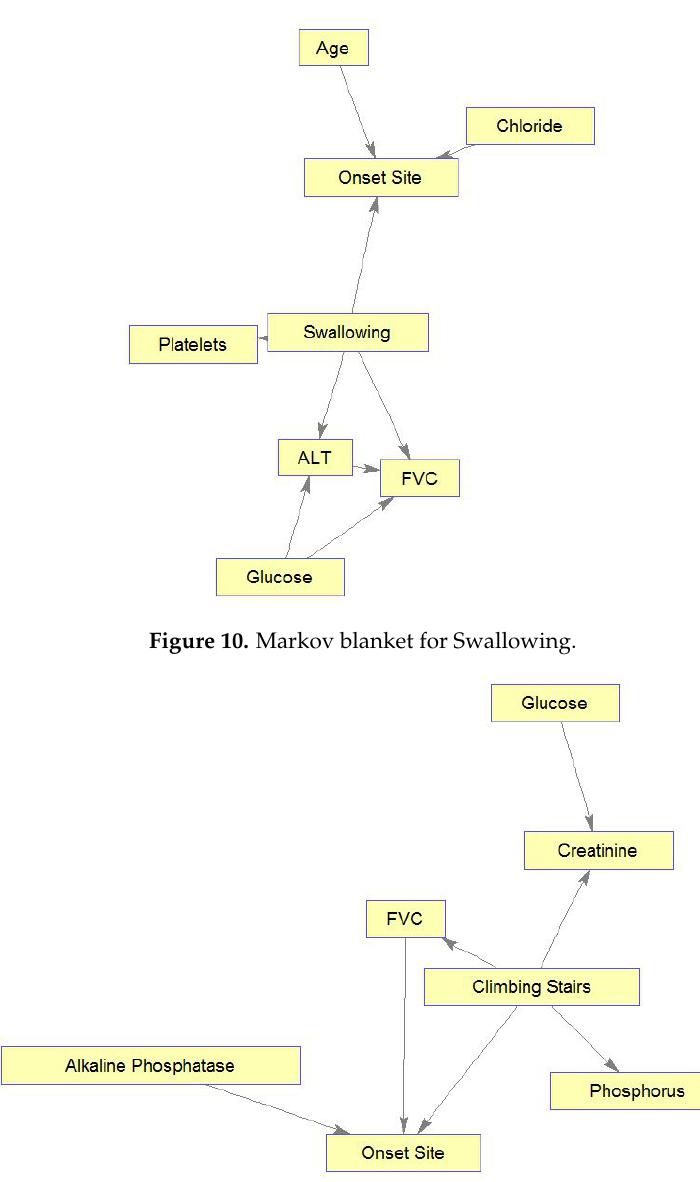
Figure 11. Markov blanket for Climbing